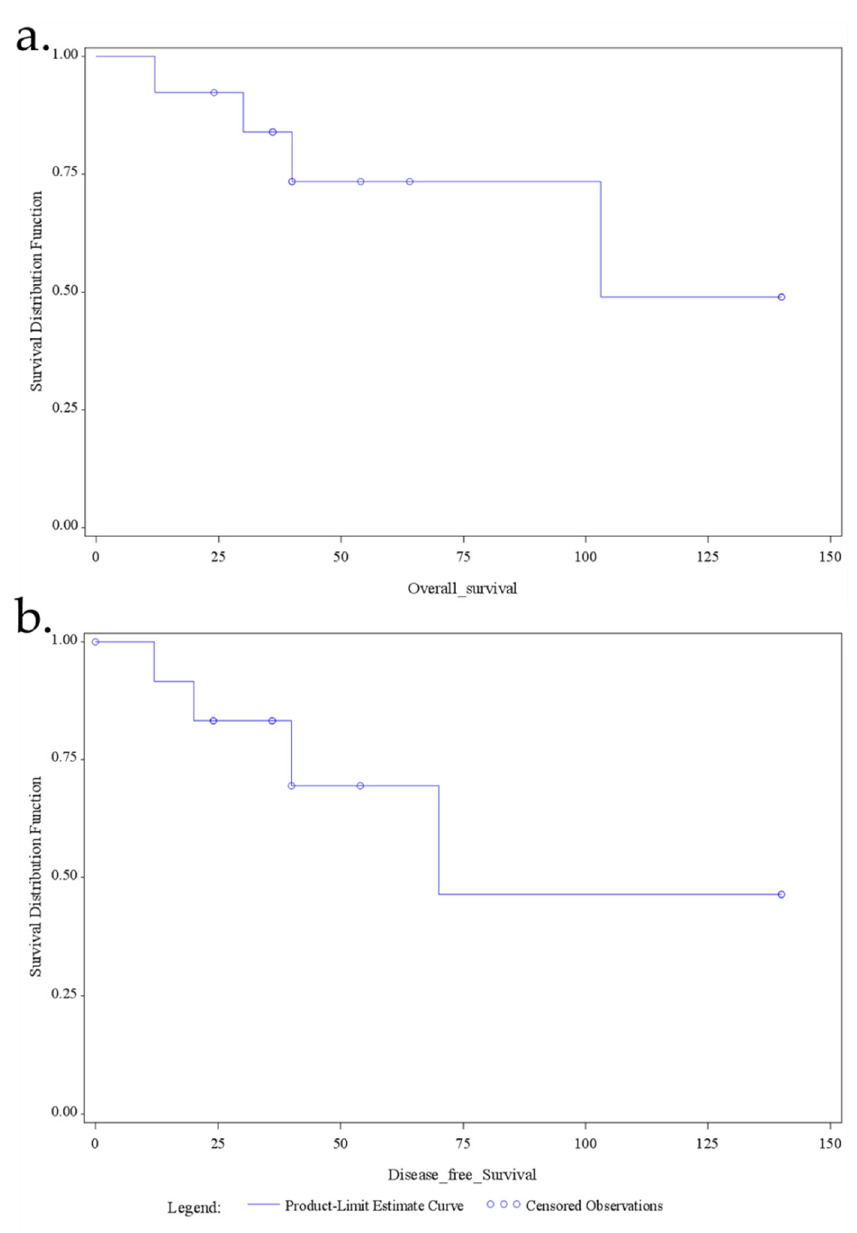
Figure 2. Kaplan–Meier estimator shows the overall survival ( a ) and the disease-free survival ( b ) for the patients with duodenal GIST.